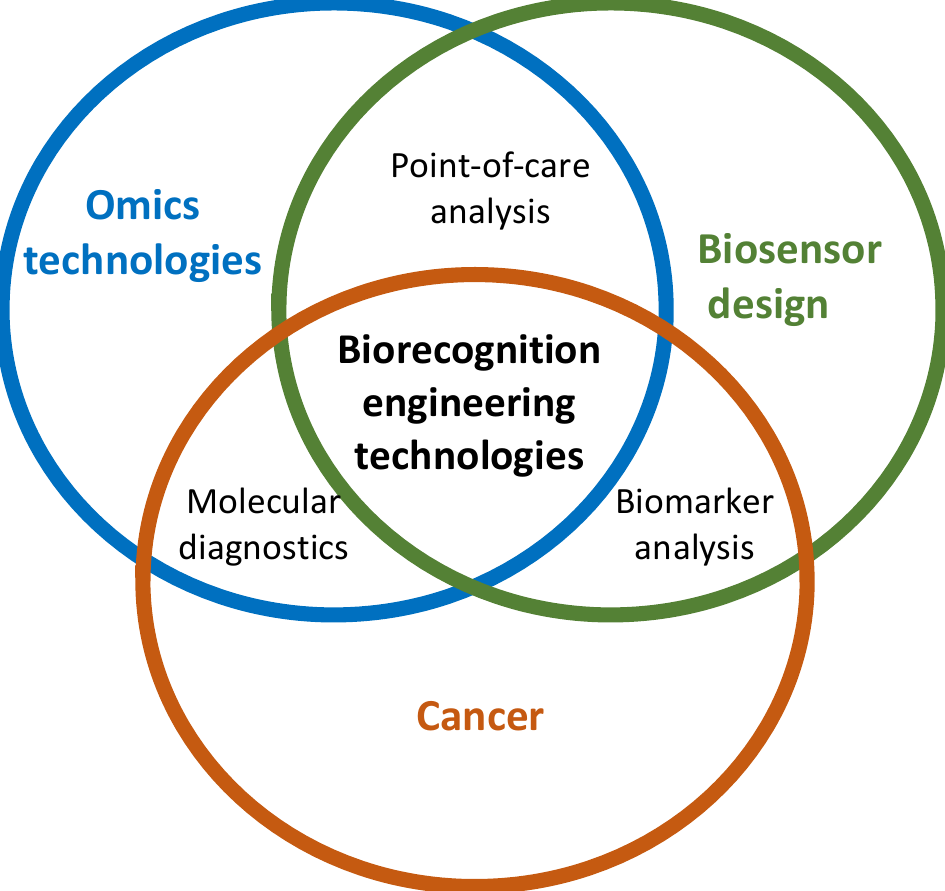
Figure 13. The Venn diagram shows the interactions of the biorecognition engineering technologies with omics technologies, biosensors, and cancer.